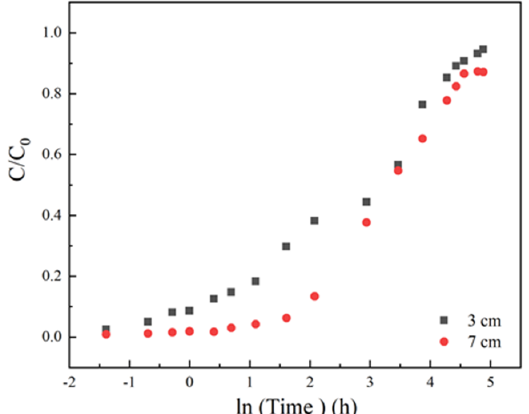
Figure 3. The adsorption effect of different column height on breakthrough curves, Experiment condition: sulfamethoxazole concentration of 35 mg/L, flow rate of 3 mL/min, pH 6.5, column height 3, 7 cm, respectively.